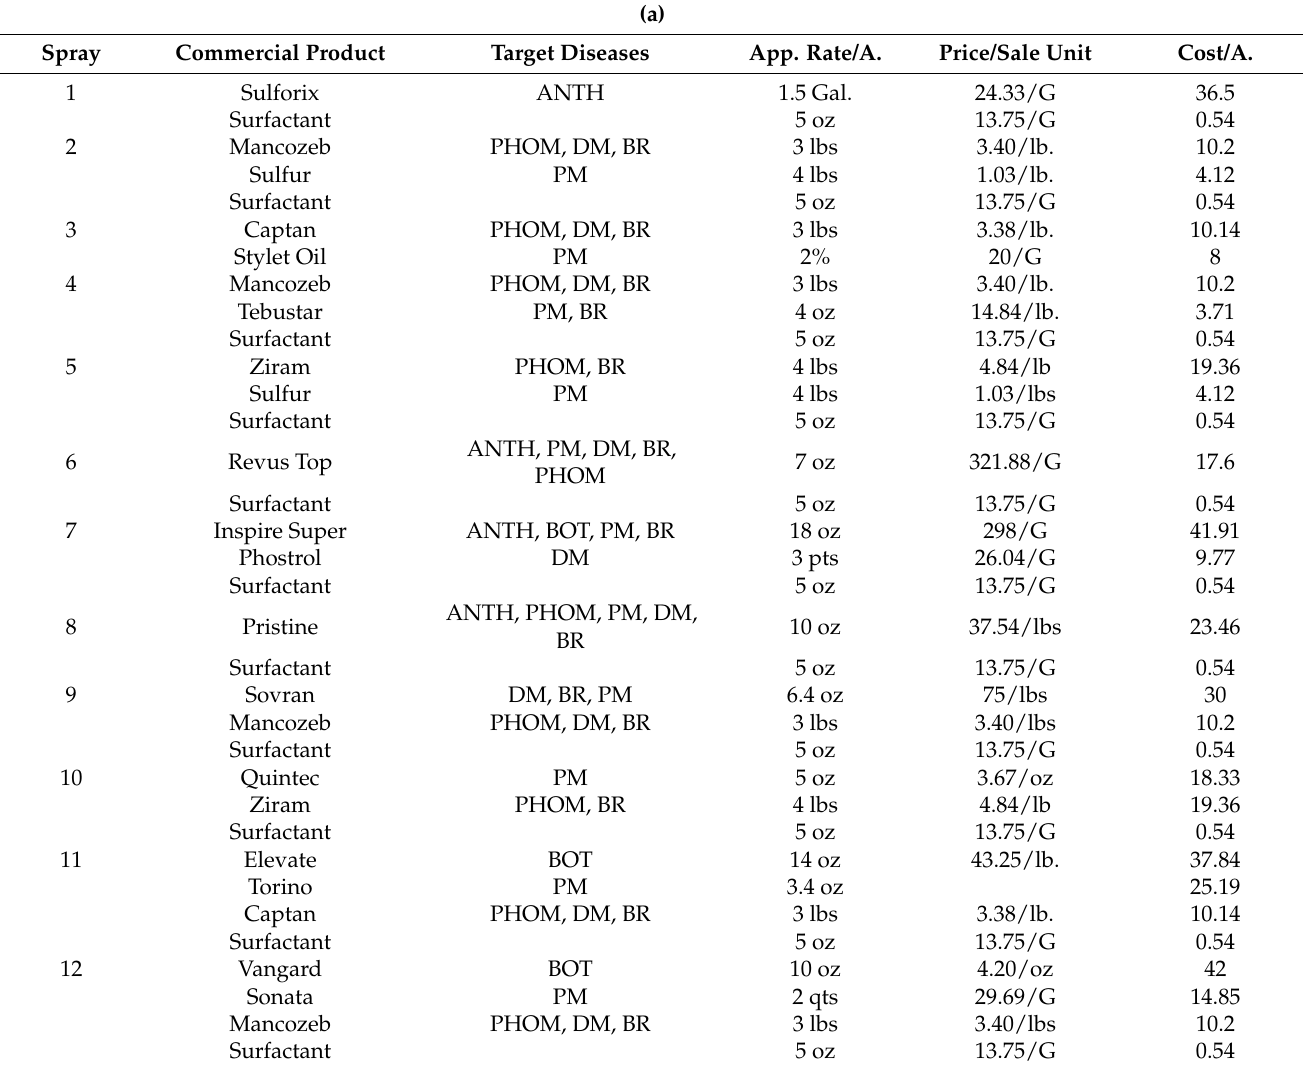
Table 6. ( a ) Fungicide program considered in the sample budget of a 30-acre Cabernet franc vineyard, for productive years only (from year 4 on). ( b ) Insecticide program used for productive years in the sample budget of a vinifera